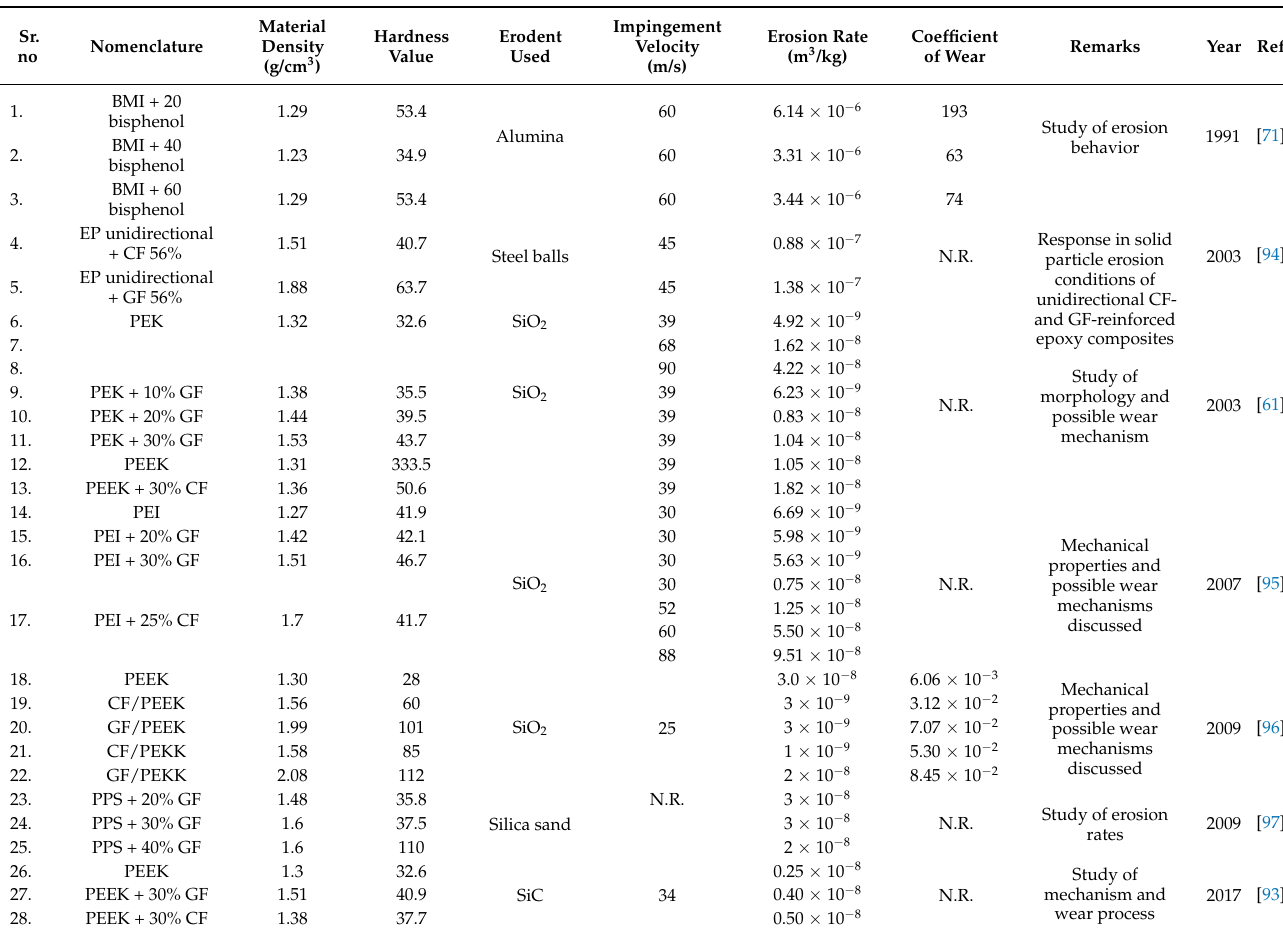
Table 2. Data on the erosion rates of GF/CF-reinforced